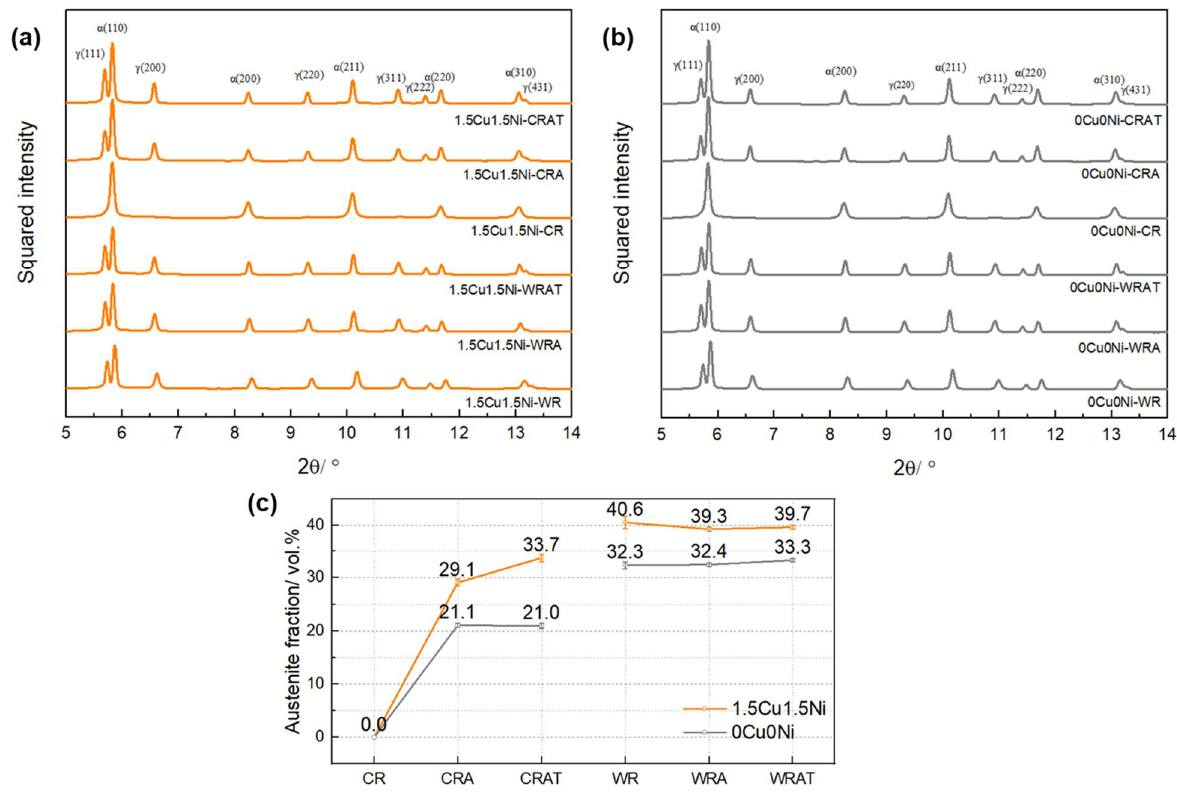
Figure 4. SYXRD spectra of ( a ) 1.5Cu1.5Ni and ( b ) 0Cu0Ni specimens; ( c ) austenite fraction of the specimens.